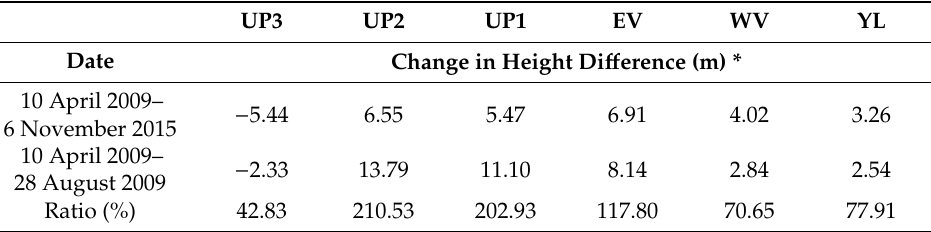
Table 4. Topographic change in the river